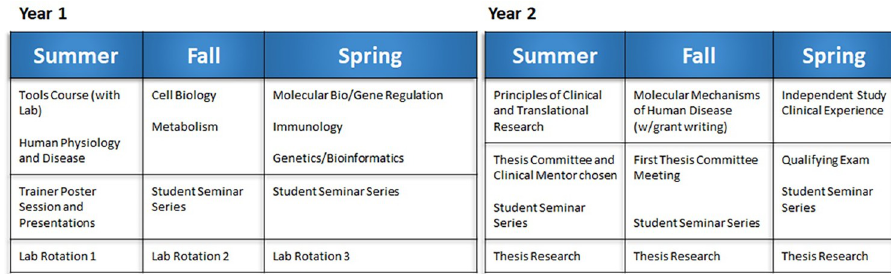
Fig 1. First two years of the current MolMed